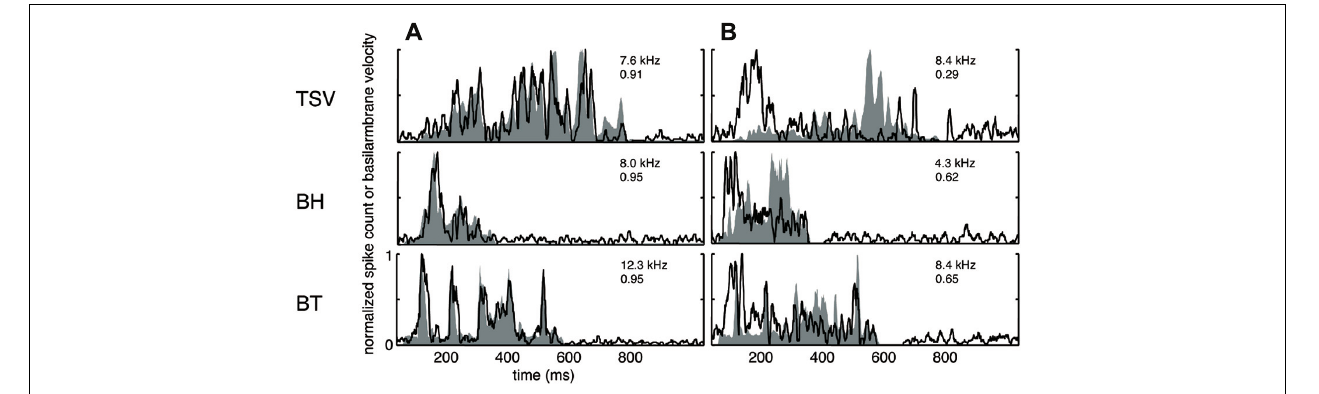
FIGURE 3 | Correlation examples. Black lines correspond to the PSTHs and gray shaded areas correspond to the DRNL outputs.The best frequency and the peak correlation value for each recording site are labeled on the top-right